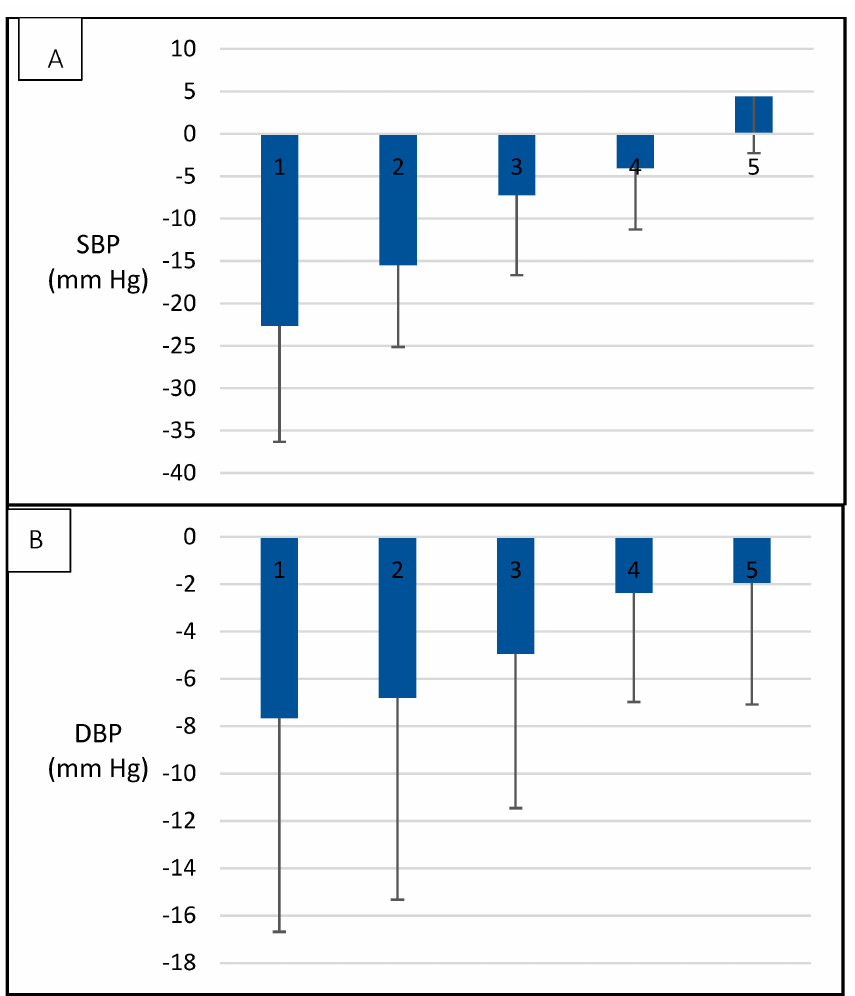
Figure 3. Association between changes in SBP and WC (Figure 2A) and DBP (Figure 2B) and changes in WC over a one-year lifestyle intervention. Groups 1 to 5 represent the distribution of participants according to the difference in WC between T0 and T12. 1, loss between 15.1 and 20 cm ( n = 2); 2, loss between 15 and 10.1 cm ( n = 9); 3, loss between 10 and 5.1 cm ( n = 20); 4, loss between 5 and 0.1 cm ( n = 46); and 5, gain between 0 and 4.9 cm ( n =